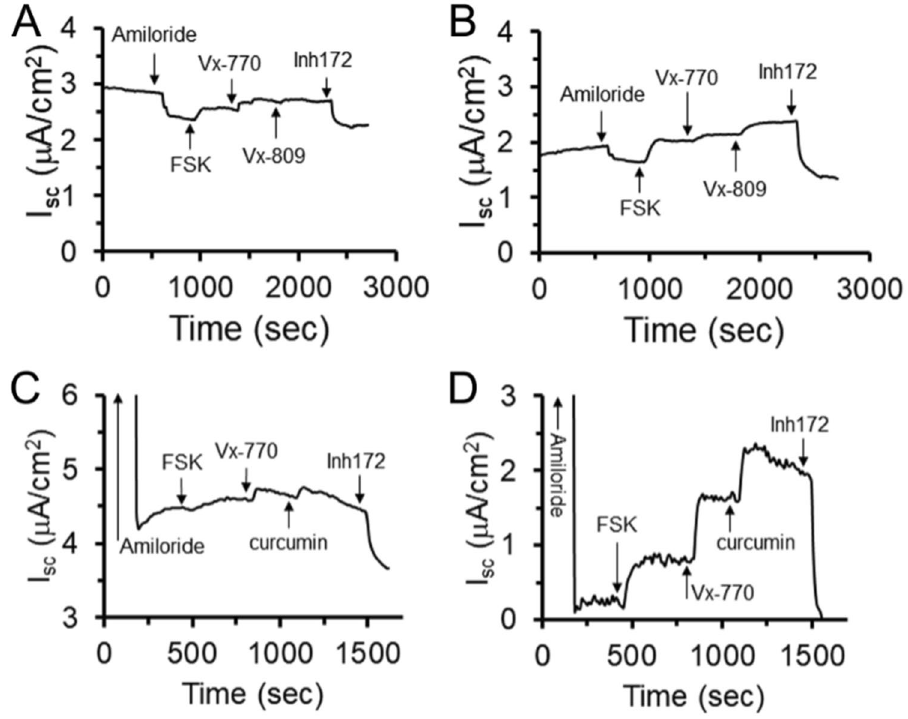
Figure 7. Representative electrophysiological analysis of primary nasal CF airway epithelia expanded using CRC conditions and differentiated in E-ALI. ( A , B ) CFhNE cells with the G551D/F508del genotype were expanded using CRC conditions to P4 and differentiated in E-ALI for 14 days. Shown are two representative traces demonstrating low levels of CFTR currents and modest responses to Vx-770 and Vx-809. ( C , D ) CFhNE cells with the W1282X/F508del genotype were expanded and differentiated as described above. Shown are two representative traces demonstrating low levels of CFTR currents and responses to Vx-770 and curcumin.